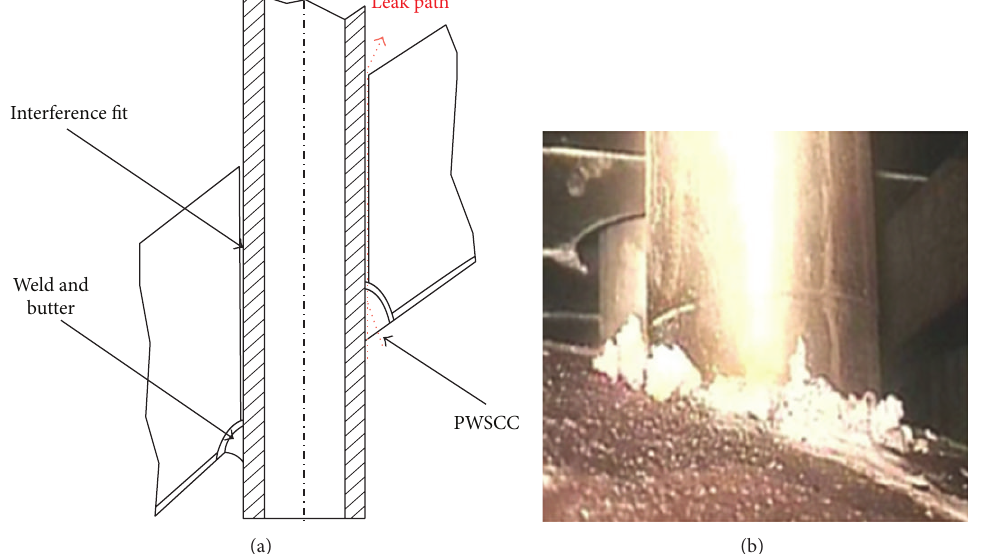
Figure 2: (a) Leak path of primary coolant by PWSCC, (b) Boric acid deposits